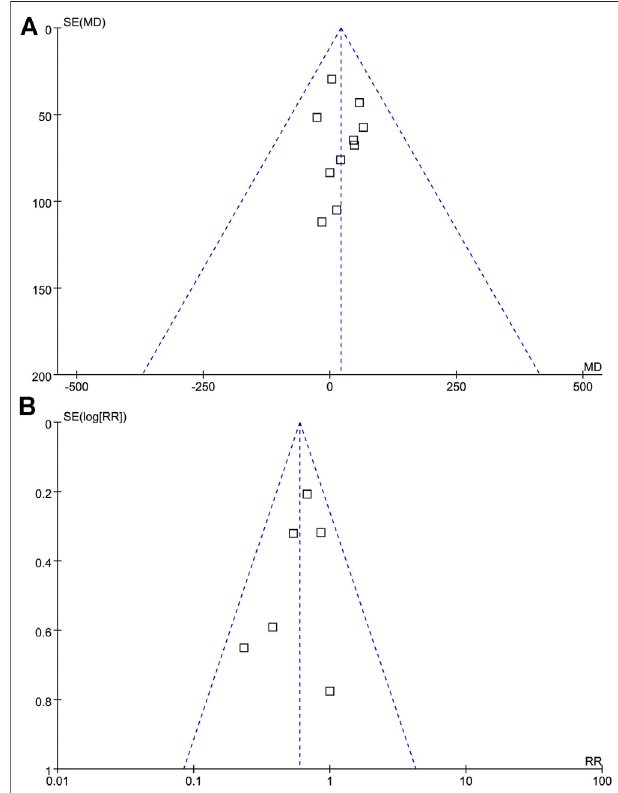
FIGURE 5 | Funnel plot analysis. Funnel Plot detailing publication bias in the studies reporting the impact of probiotics on CD4 cell count (A) , and probiotics on the incidence of AIDS-related diarrhea (B) . There is no evidence of publication bias.